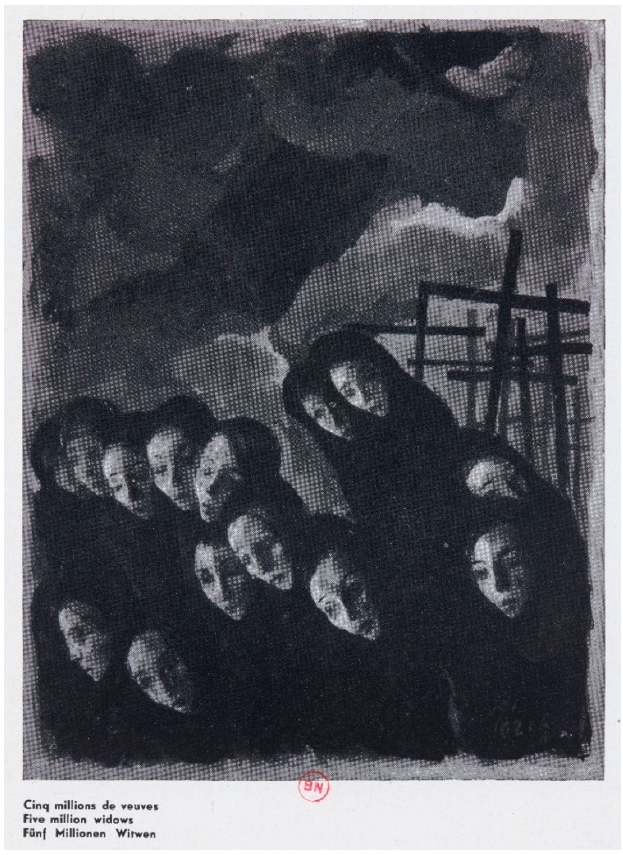
Figure 5. Imre Pérely. “Five Million Widows.” War. 1931. Lithograph. Bibliothèque Nationale de France. Figure 5. Imre P é rely. “Five Million Widows.” War. 1931. Lithograph. Biblioth è que Nationale de